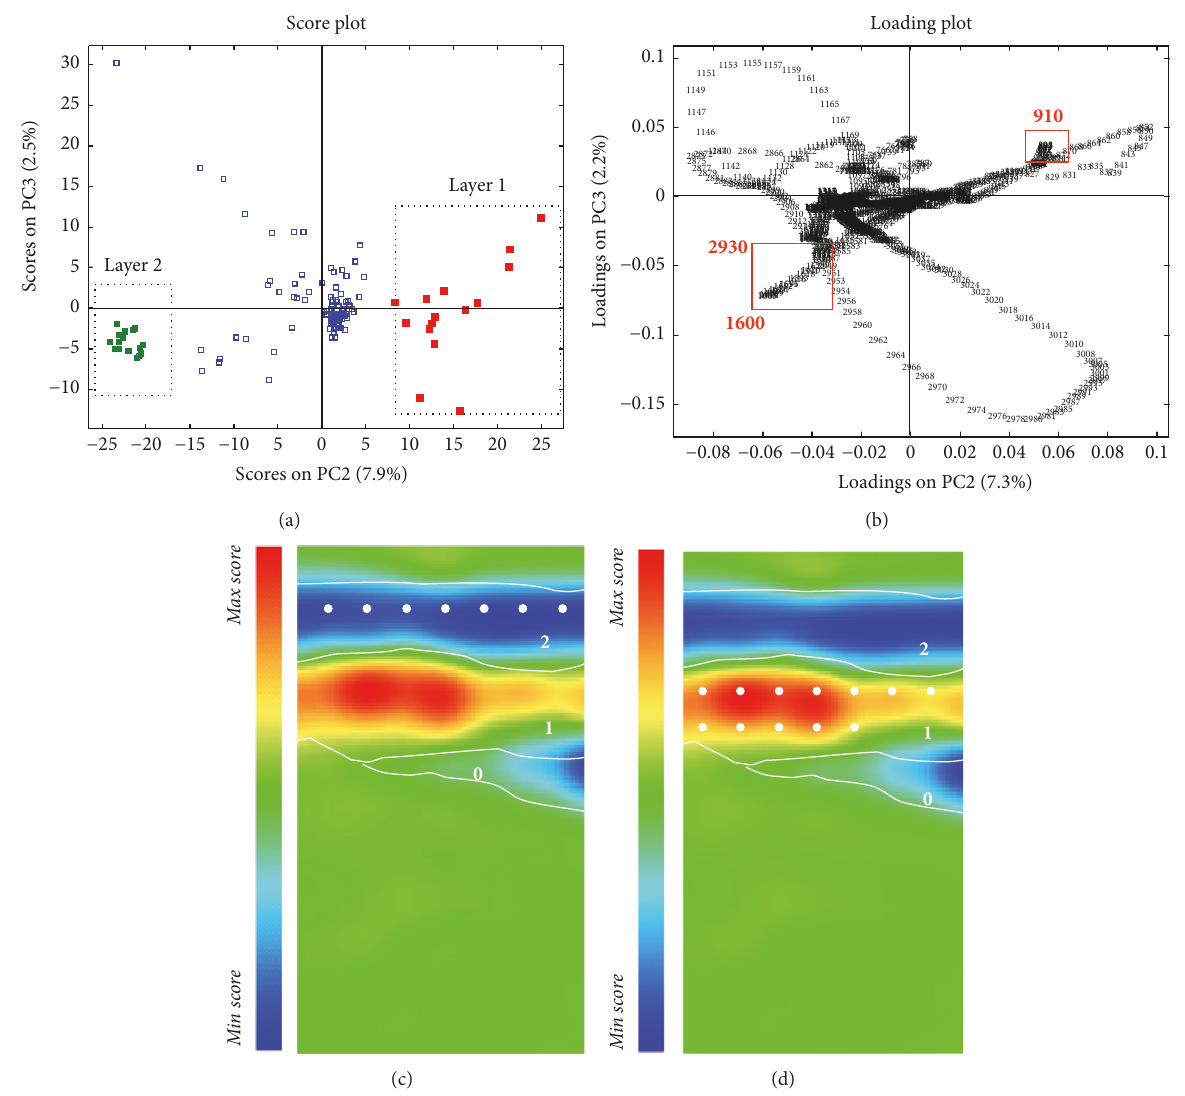
Figure 2: Sample 15r1. (a) PC23 score plot: clusters highlighted in red indicate the objects points localised within layer 2 (white dots in (c)) and green for points localised within layer 1 (white dots in (d)); (b) PC23 loading plot; (c, d) PC2 score